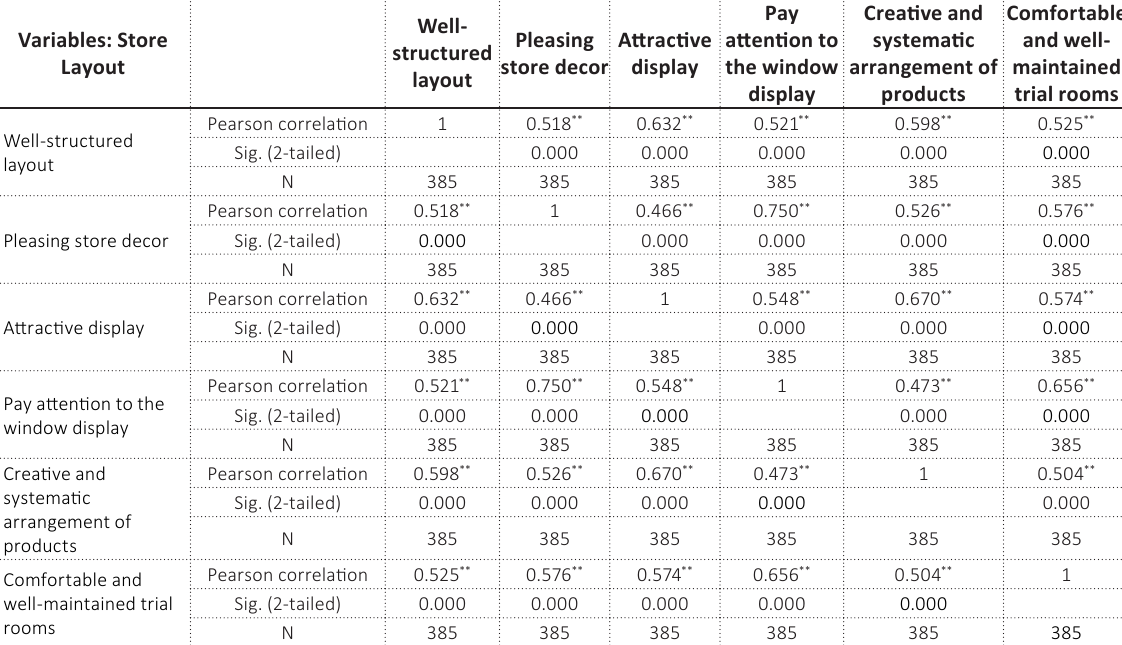
Table 3 interprets the convergent validity of store